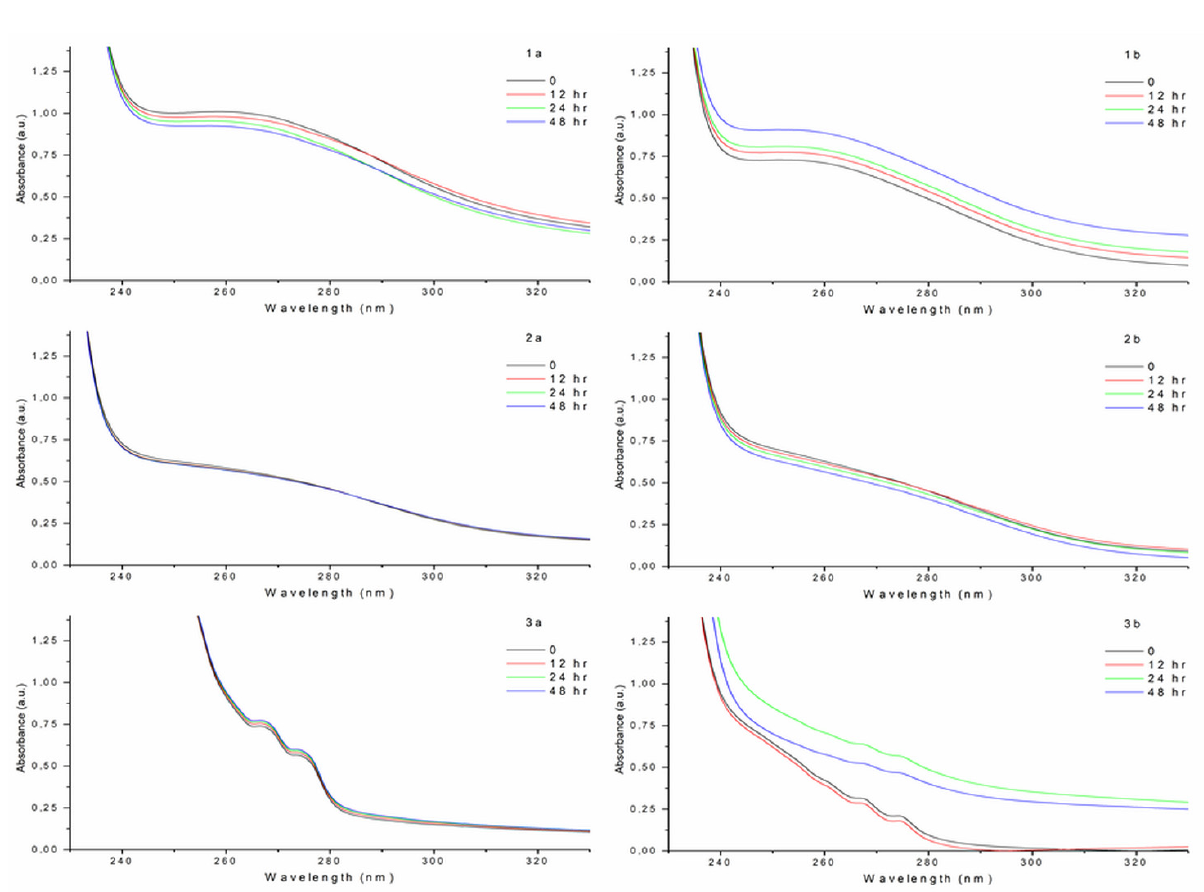
Figure 6. Ultraviolet–visible (UV–Vis) absorption spectra of the gold(I) complexes (50 µM) in phosphate-buffered saline (PBS) ( 1a – 3a ) and in cell culture medium ( 1b – 3b ) over 48 h.